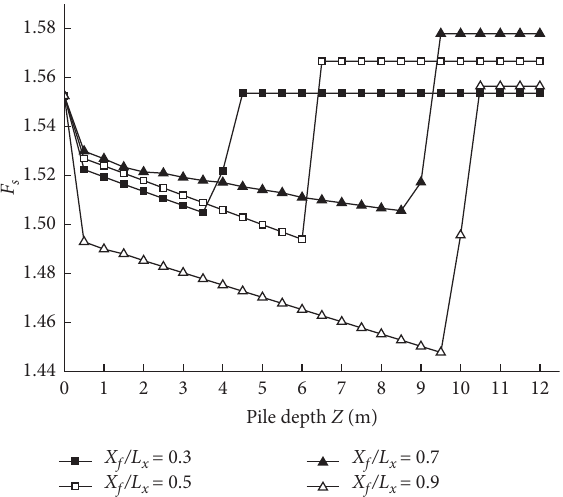
Figure 10: Effects of pile location X slopes. Figure 8: Effects of the inclined angle of soil on the stability of 3D